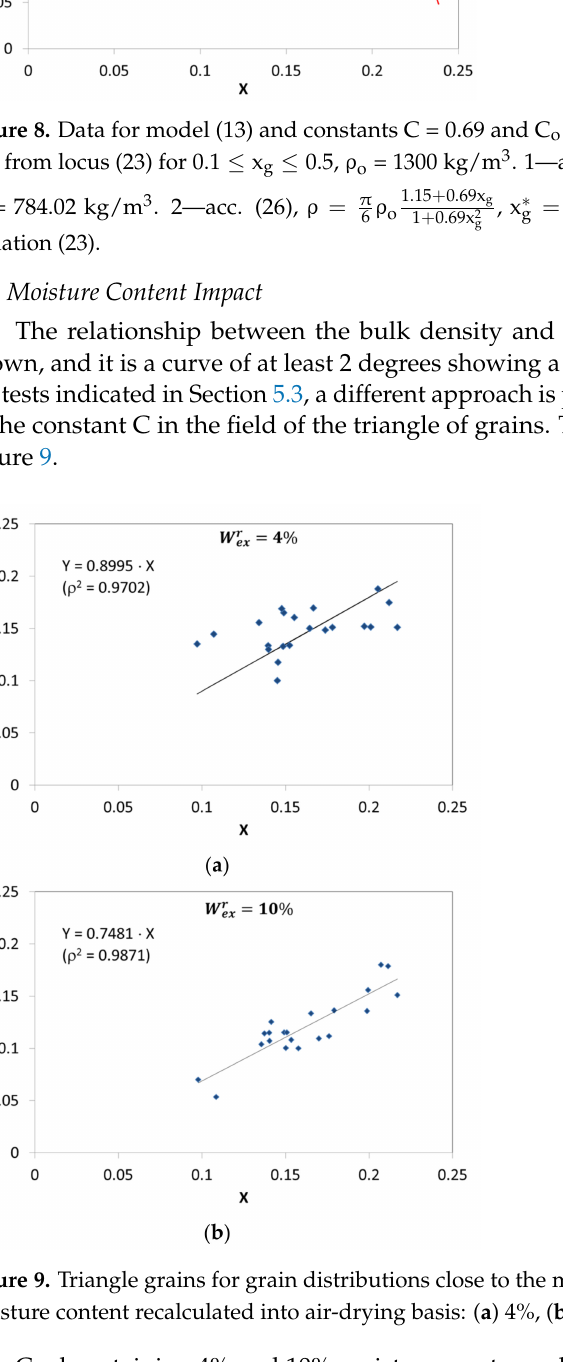
1 + 0.69x g ρ , x ∗ g = 0.4348, o 6 1 + 0.69x 2 g